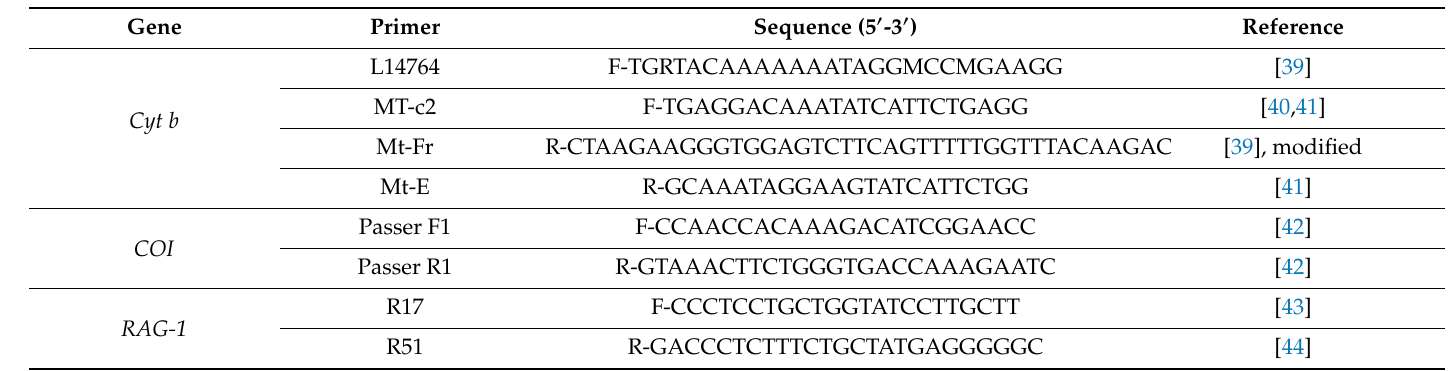
Table 2. Primers used in this